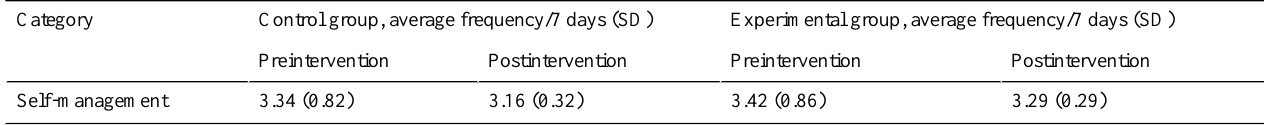
Table 6. Self-management of exercise behavior.